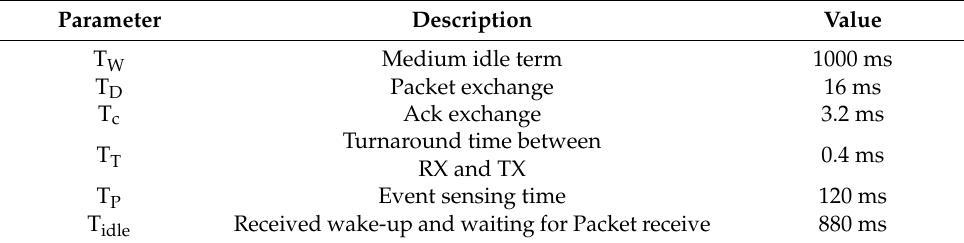
Figure 3. Node communication considering wake-up schedule. Table 1. Node communication time parameters based on WiseMAC